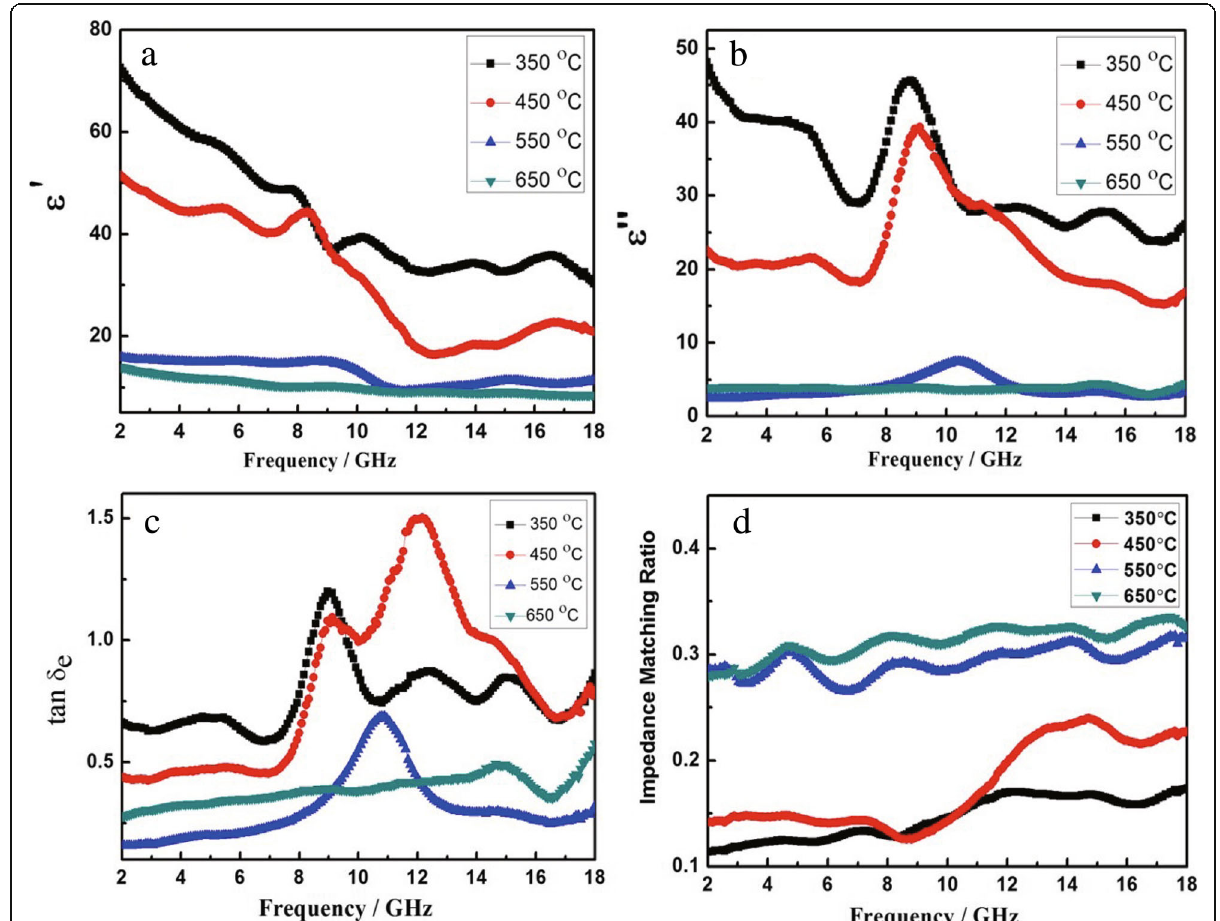
Fig. 4 Frequency dependences of ε ′ ( a ) and ε ″ ( b ) of the mixtures with different calcining temperature. Dielectric loss factor ( c ) and impedance matching rate ( d ) of the samples by synthesized at different temperatures for frequency